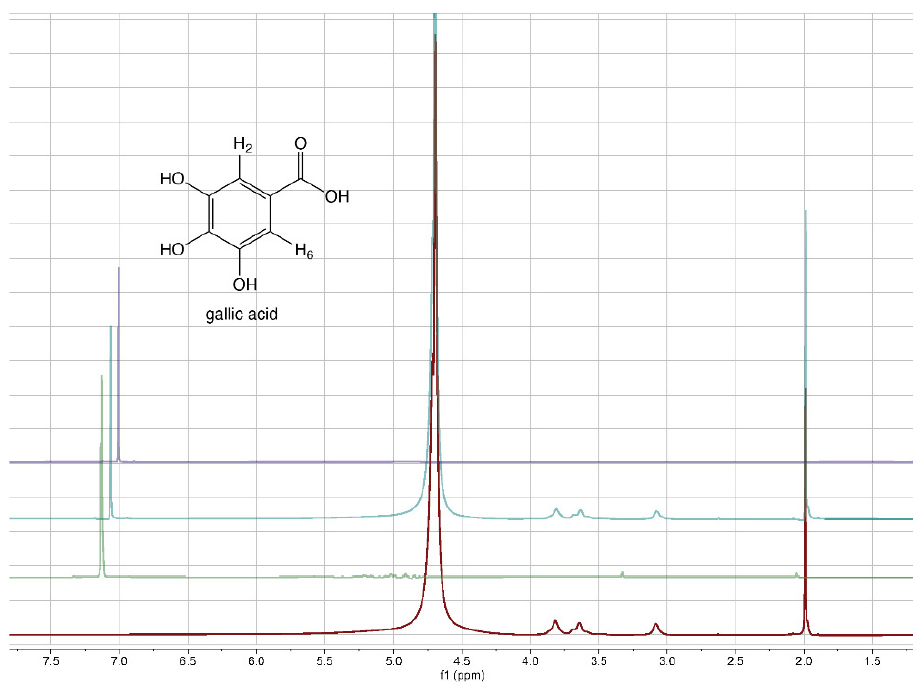
Figure 1. 1 H-NMR spectra of 3D chitosan at pH 3.5 (red), GA at pH 3.5 (green), HL-3D chitosan-GA complex at pH 3.5 (cyan), and GA at pH 6.0 (purple). All spectra were recorded at 25 ◦ C in 9:1 H 2 O/D 2 O.